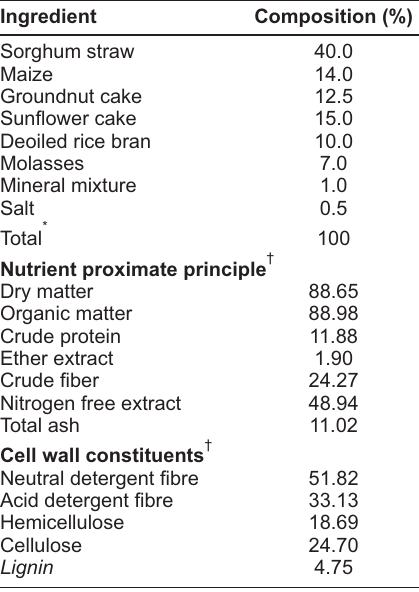
Table-1: Ingredient and chemical composition (%) of the experimental complete ration. Ingredient Composition (%)